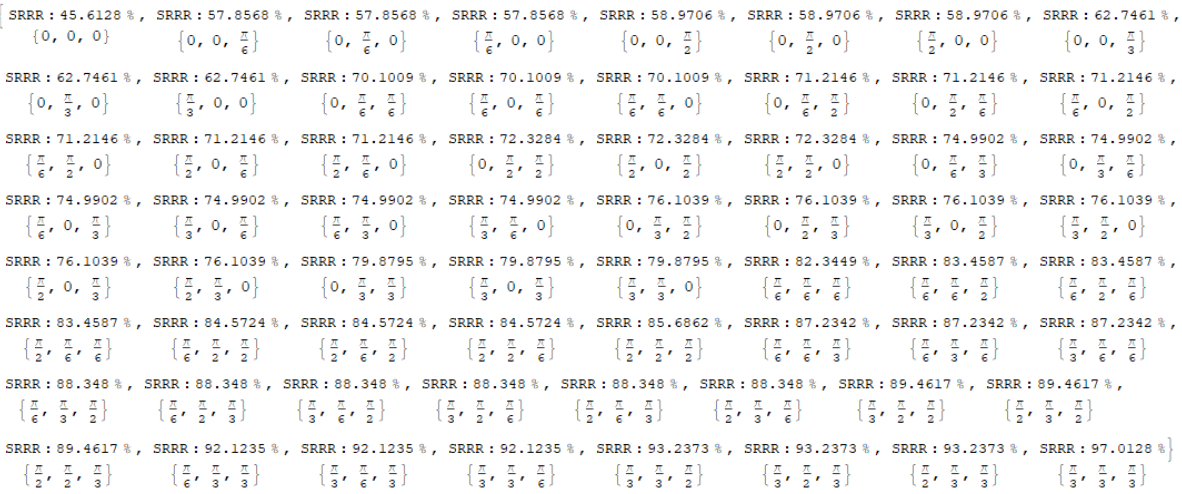
Makkah, Saudi Arabia.